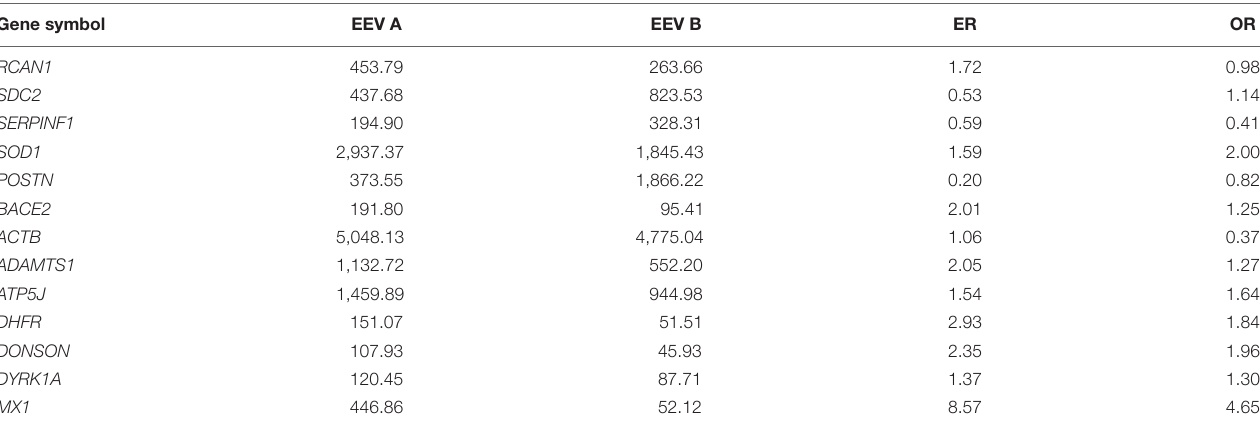
From left to right: official symbol of the gene; expected expression value (EEV) of each gene in Pool A and Pool B calculated by TRAM; expected ratio (ER) between DS and non-DS fibroblasts provided by TRAM; observed ratio (OR) determined by Real-Time RT-PCR with the method of 2 − (cid:49)(cid:49) Ct provided by Bio-Rad CFX Manager Software